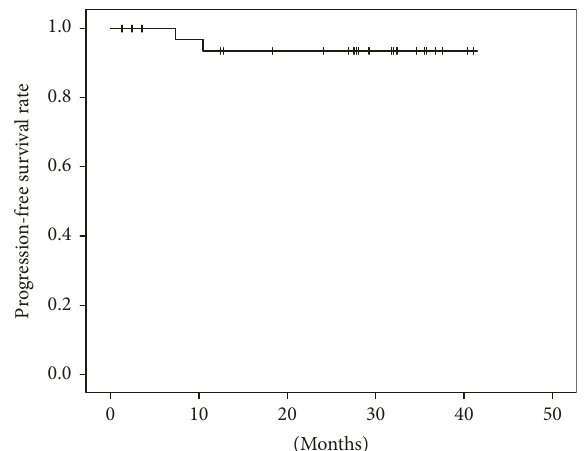
Figure 4: Kaplan-Meier curves for progression-free survival rate in 22 patients with 36 pulmonary metastases from colorectal cancer after MWA treatment.